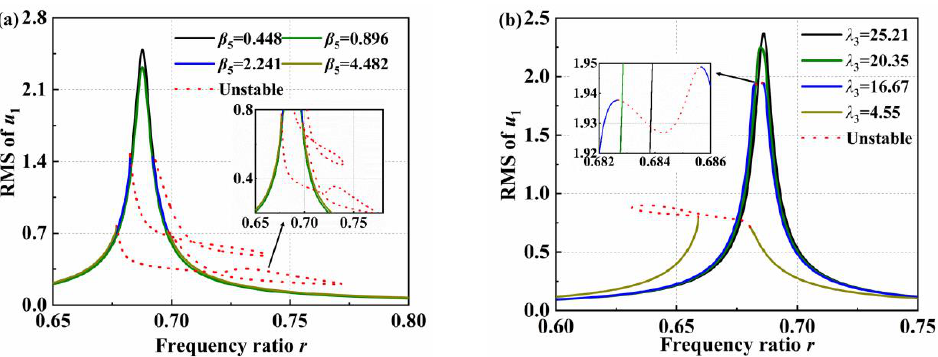
Figure 5. The root-mean-square of u 1 with the different parameters of the VS-TMD-I: ( a ) negative stiffness ratio β 5 ; ( b ) inertance ratio λ 3.